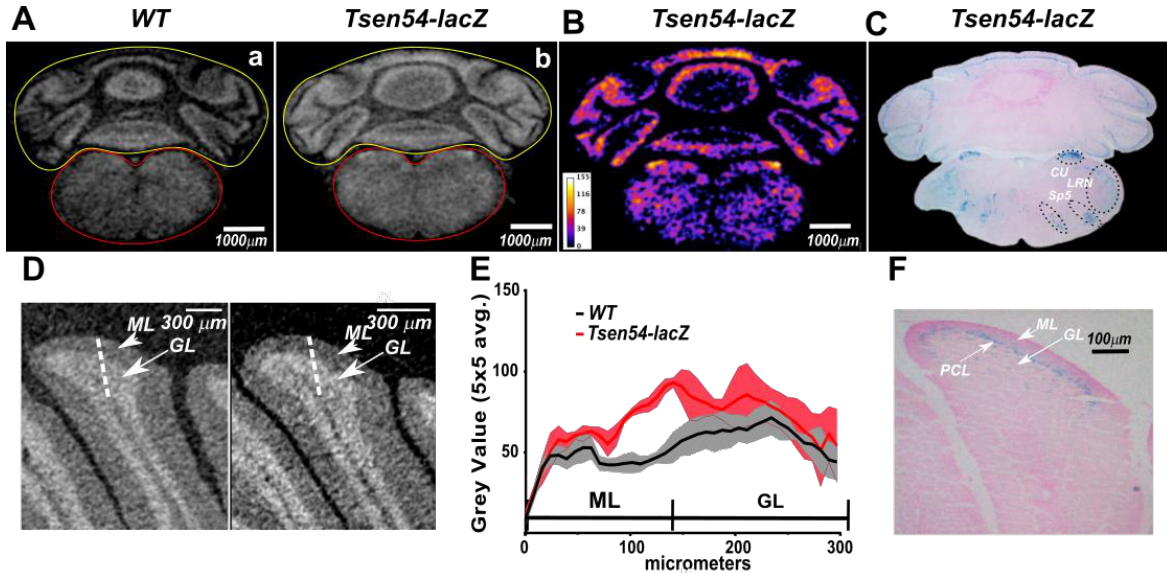
Figure 3. Comparative analysis of virtual X-ray and histological sections in hindbrain region. ( A ) Representative 2D virtual sections from hindbrain region of wild type ( a ) and Tsen54-lacZ ( b ) brains. Segmentation lines are indicated: yellow—cerebellar lobes, and red—brainstem. Resolution of the micro-CT scan is 20 µ m/voxel. ( B ) Segmentation analysis of the 2D micro-CT hindbrain section. The LUT function was set from a 0 to 155 grayscale value interval. ( C ) Histological section of hindbrain from the Tsen54-lacZ brain. The regions with the highest expression in brainstem are indicated: CU—cuneate nucleus; Sp5—spinal nucleus of trigeminal; LRN—lateral reticular nucleus. ( D ) Two-dimensional micro-CT-acquired image of the simple cerebellar lobule from the Tsen54-lacZ and wild type animals at 5 µ m/voxel resolution. The punctate lines indicate the regions selected for density quantification. Arrows indicate the cerebellar love layers. ( E ) Averages of brightness values, corrected for background, from Tsen54-lacZ (N = 3) and wild type (N = 3) cerebellar lobules, were plotted as a function of distance. ( F ) Histological analysis of the simple cerebellar lobule of cerebellum from the whole-mount X-gal/FeCN stained brains. ML—molecular layer; PCL—Purkinje cell layer; and GL—granular